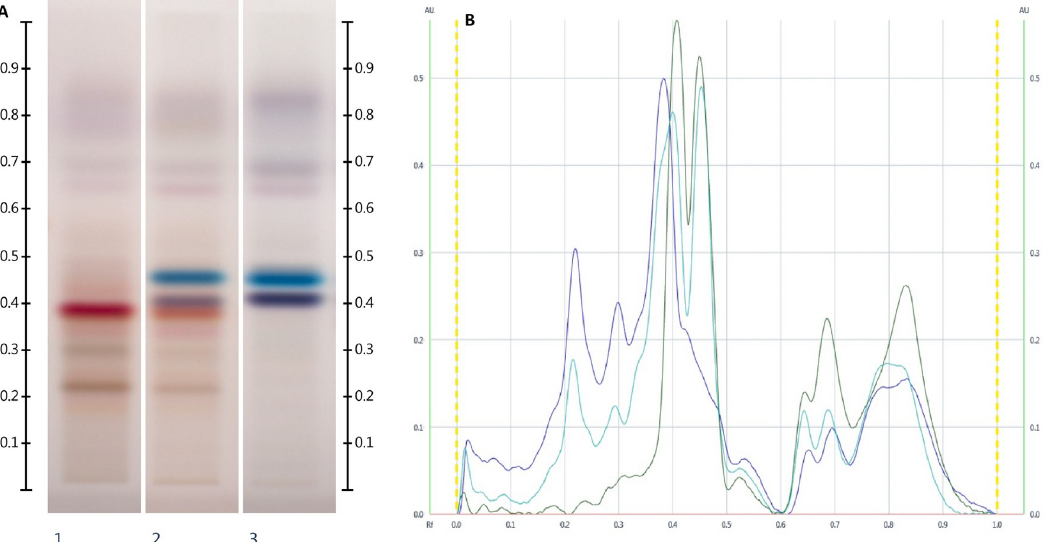
Fig 1. Images taken at White light after derivatisation with vanillin reagent; Track 1 –JAR, Track 2 –multifloral honey (JAR mixed with BAS), Track 3 –BAS (a), and their respective chromatograms (b); 5 μ L of each extract respectively.